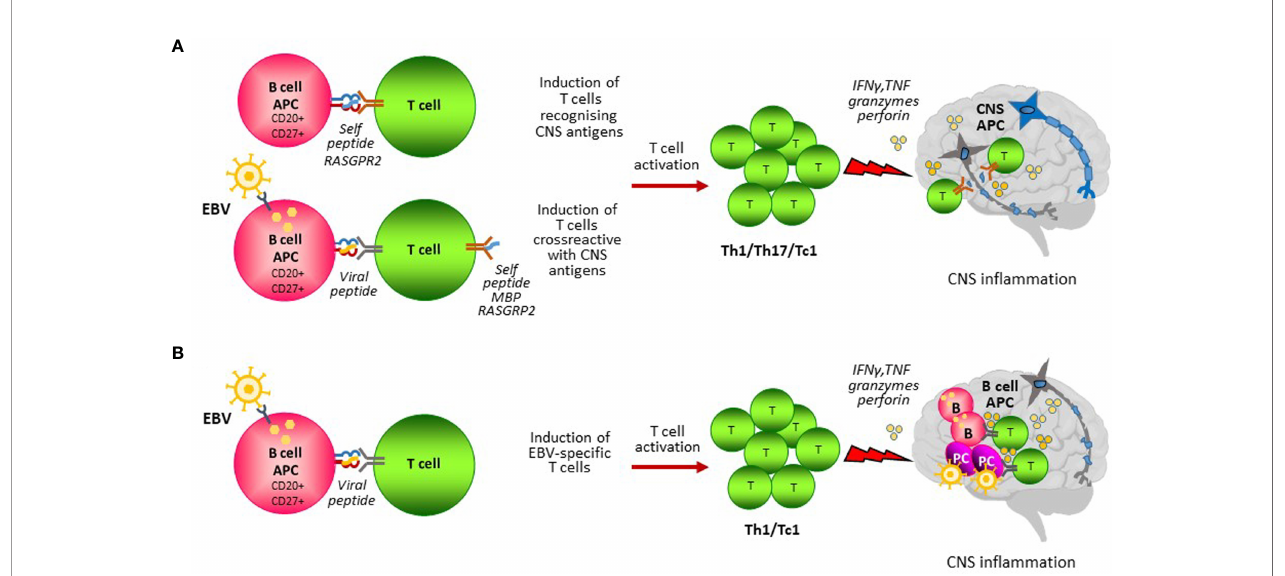
FIGURE 1 | B cell antigen presentation in MS. B cells could contribute to the activation of pathogenic T cells through presentation of self and non-self antigens. (A) CD27+ CD20+ memory B cells could present self-peptides from proteins that are expressed in the CNS leading to the induction of autoreactive T cells. Infection of B cells with EBV induces EBV-speci fi c T cells that exert continuous immune surveillance and are essential for virus-host homeostasis. EBV infected B cells could induce autoreactive T cells by presenting EBV peptides sharing similarities with peptides from CNS self-antigens (i.e. MBP, RASGPR2) (molecular mimicry). Autoreactive T cells homing to the CNS would recognize their target antigen on local antigen presenting cells (APC) and become reactivated causing CNS in fl ammation and tissue injury. (B) EBV infected CD27+ CD20+ memory B cells induce EBV-speci fi c T cells that migrate in the CNS to counteract an abnormal EBV infection brought inside the CNS by circulating infected B cells. In this model, B cells would act as APC both in the periphery and in the CNS to stimulate a detrimental antiviral immune response causing CNS in fl ammation and tissue